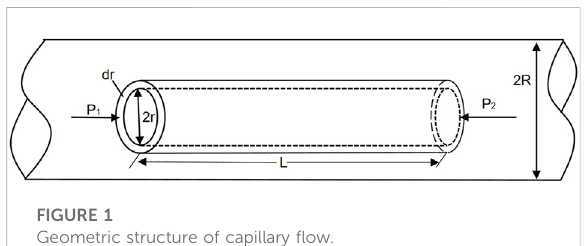
FIGURE 1 Geometric structure of capillary fl